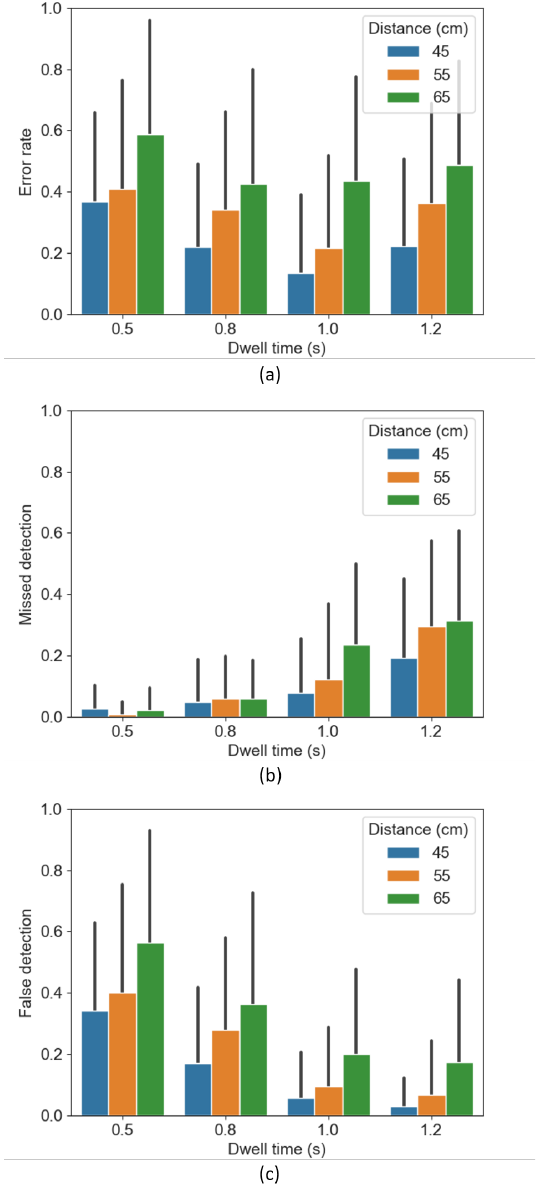
Figure 9. The average error rate, false detection rate and missed detection rate, error bars represent the standard